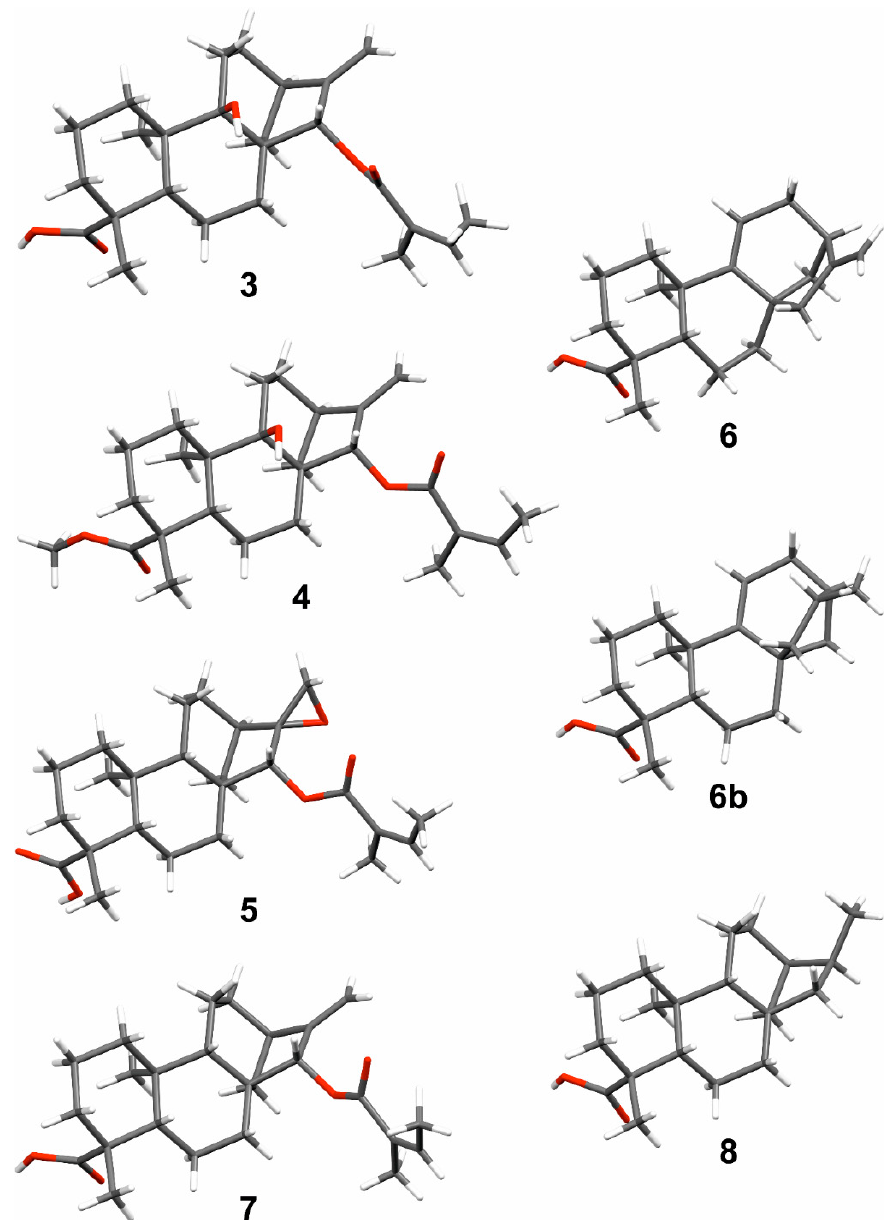
Figure 4. Crystal structure representations of compounds 3 – 8 . The structures were deposited with the following CCDC (Cambridge Crystallographic Data Centre) codes: 3 (1868318), 4 (1868319), 5 (1868321), 6 (1868320), 6b (1868324), 7 (1868323), and 8 (1868322).